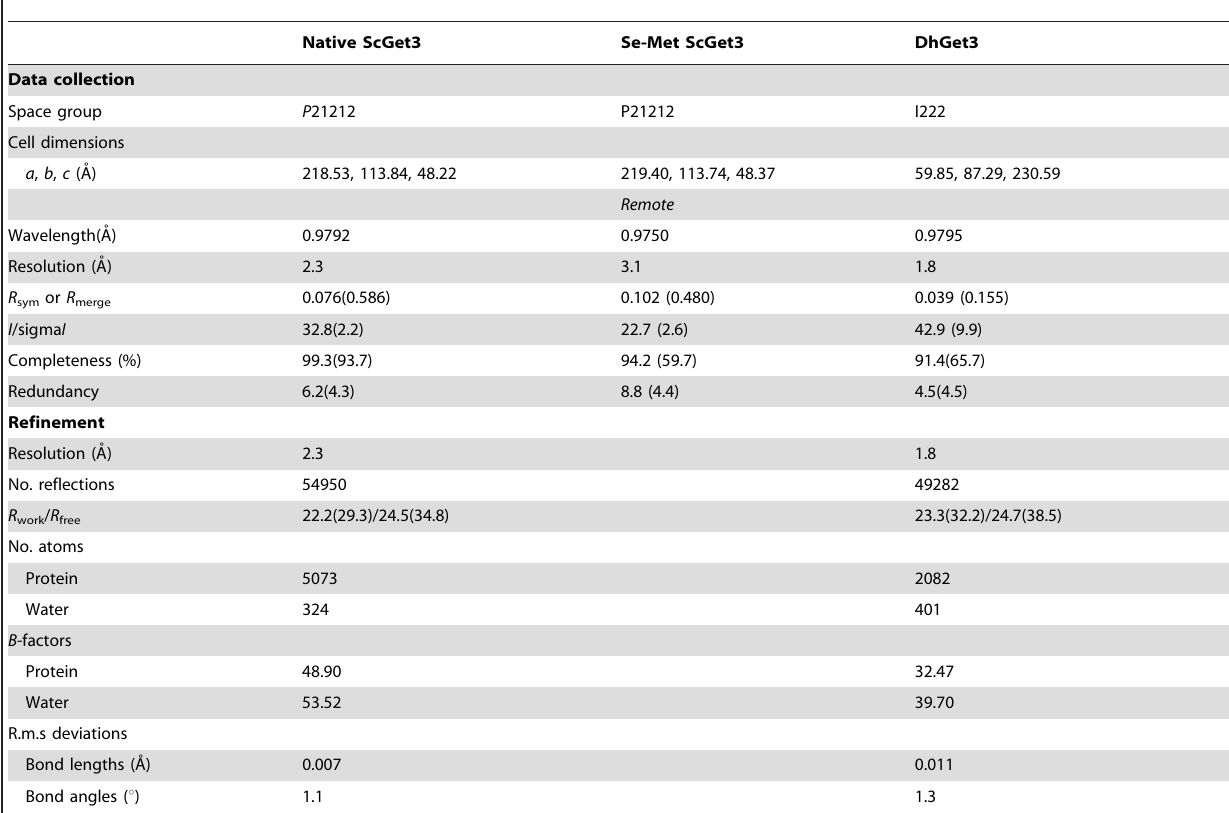
Table 1. Data collection, phasing and refinement statistics for S. cerevisia and D. hansenii Get3